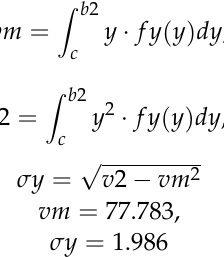
Figure 5. The probability density plot— G 4. Characteristics of the random variable y = G 4 Characteristics of the random variable 𝑦 = 𝐺4